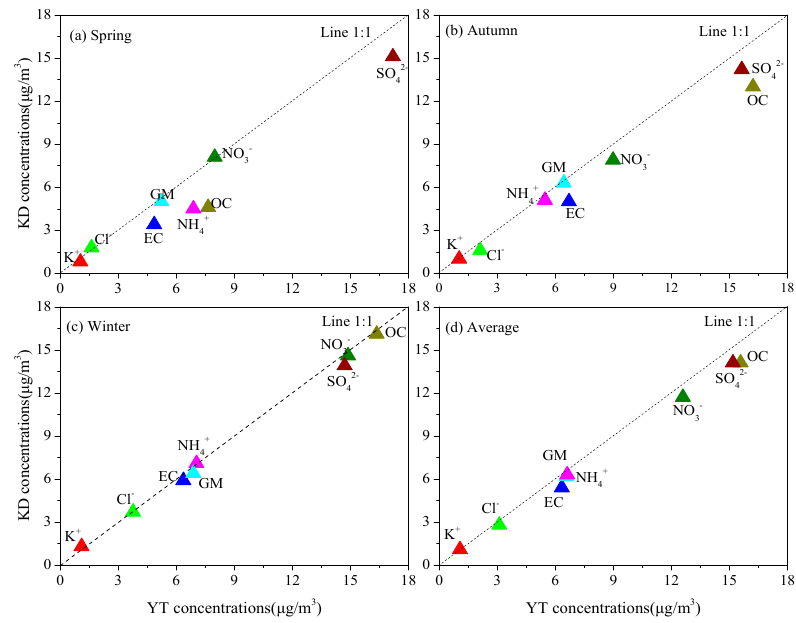
Figure 3. Seasonal mean concentrations of the major components of PM 2.5 in ( a ) spring, ( b ) autumn, ( c ) winter, and ( d ) their average concentrations during the sampling periods at the YT and KD sites.